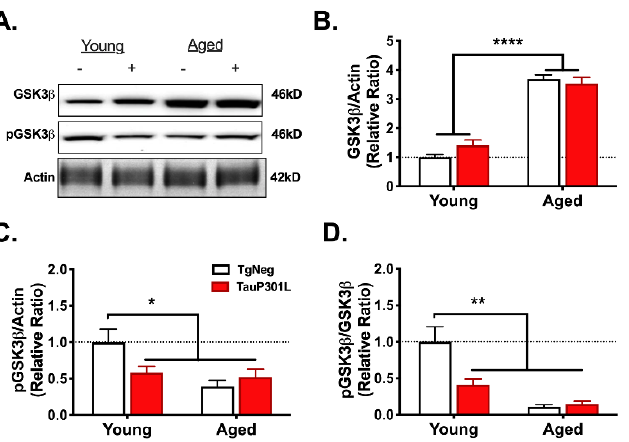
Figure 7. Age- and tau- associated changes in GSK3β activity. Age and P301L tau expression resulted in alterations in GSK3β ( A , B ) , pGSK3β ( A , C ) and the ratio of pGSK3β/GSK3β ( A , D ). * p < 0 .015; ** p < 0 .01; **** p < 0 .0001; n = 5 – 9/group. − represents TgNeg and + represents